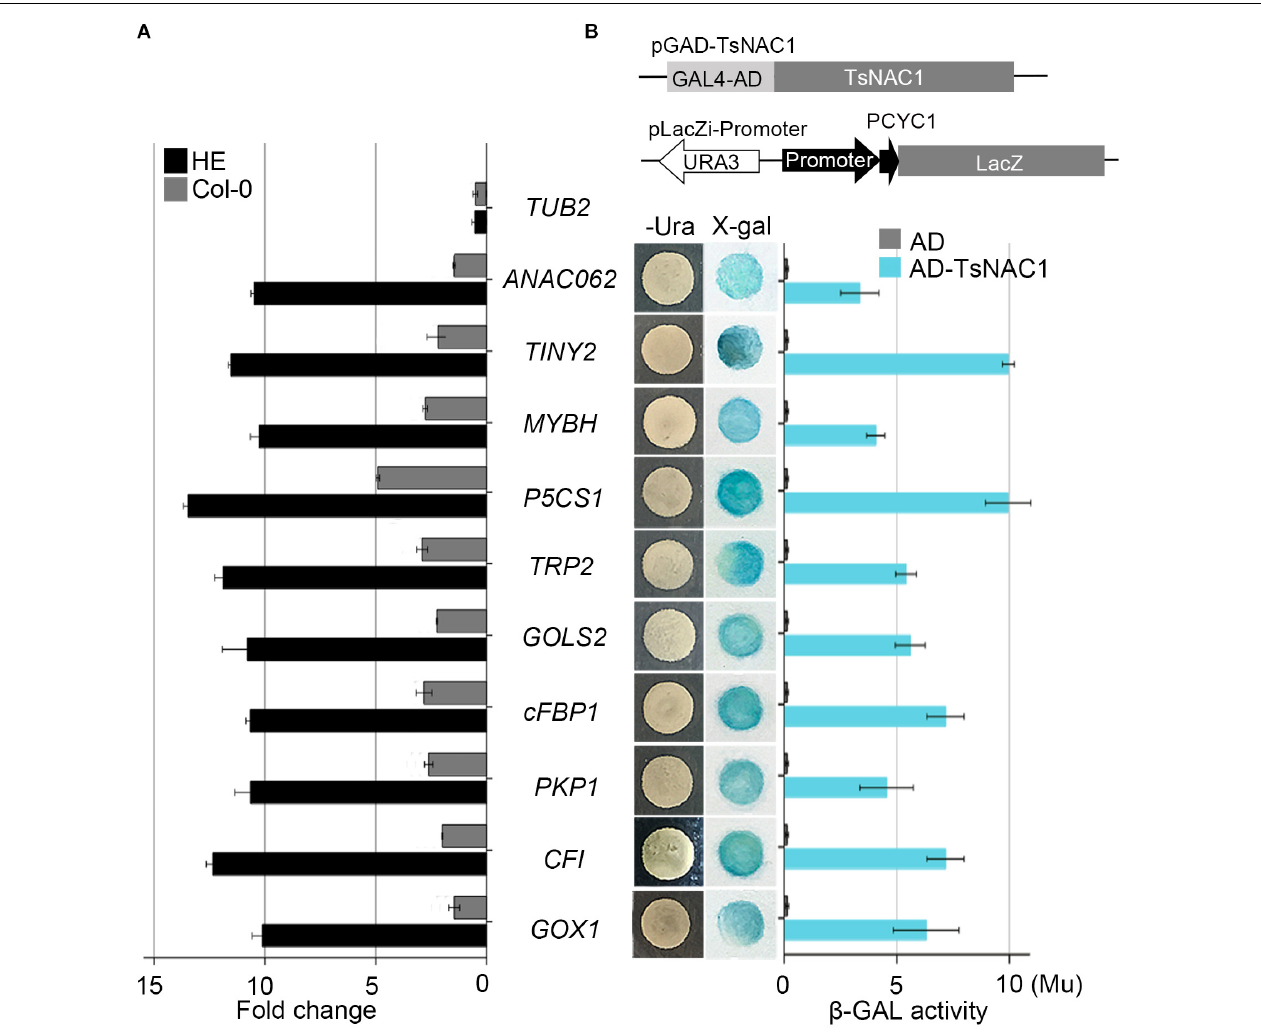
FIGURE 4 | Validation of candidate target genes. (A) Binding of EsNAC1 to the promoter of candidate target genes as determined by ChIP-qPCR. The rosette leaves of 3-week-old plants from the two HE lines were used as materials and immunoprecipitated with EsNAC1 antibody and protein A agarose beads. Negative control reactions were performed in parallel with Col-0. (B) Candidate target promoter fragments were connected into pLacZi and transformed into the pAD-GAL4- EsNAC1 YM4271 strain. X-gal staining determined β -galactosidase activities. Measures of β -gal activity were with ONPG as the substrate. β -gal units (Mu), 1,000 × OD 574 /(t × V × OD 600 ); t, elapsed incubation time (min); V, volume of culture (mL). All bars represent the mean ± SD, with three biological replicates in the